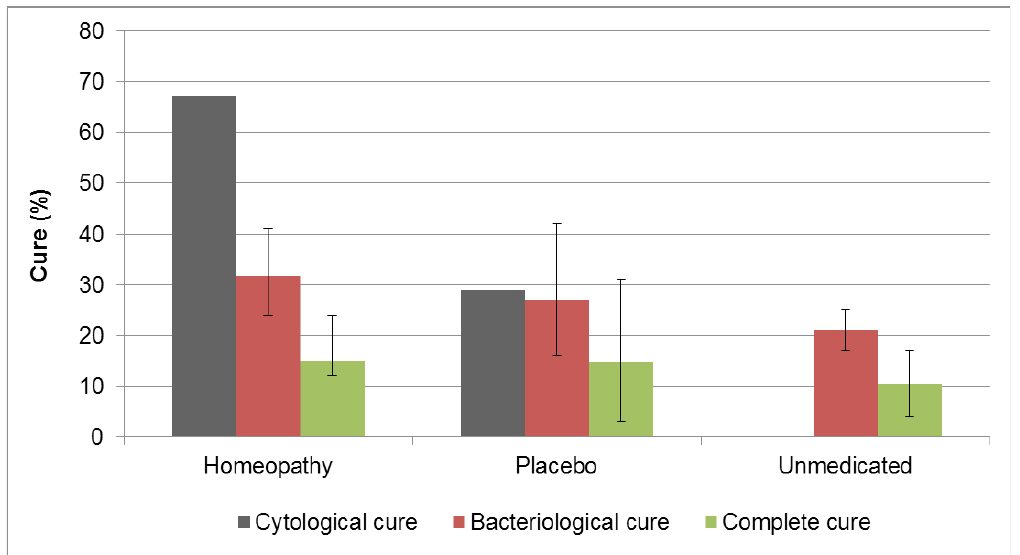
Figure 1: Cure of subclinical mastitis as percentage in three trial groups. The sample size of each test group was: Homeopathy: Searcy et al. (1995): 51 udder quarters (cytological cure); Klocke et al. (2007): 67 udder quarters (bacteriological cure, complete cure); Placebo: Searcy et al. (1995): 52 udder quarters (cytological cure); Klocke et al. (2007): 58 udder quarters (bacteriological cure, complete cure); Unmedicated: